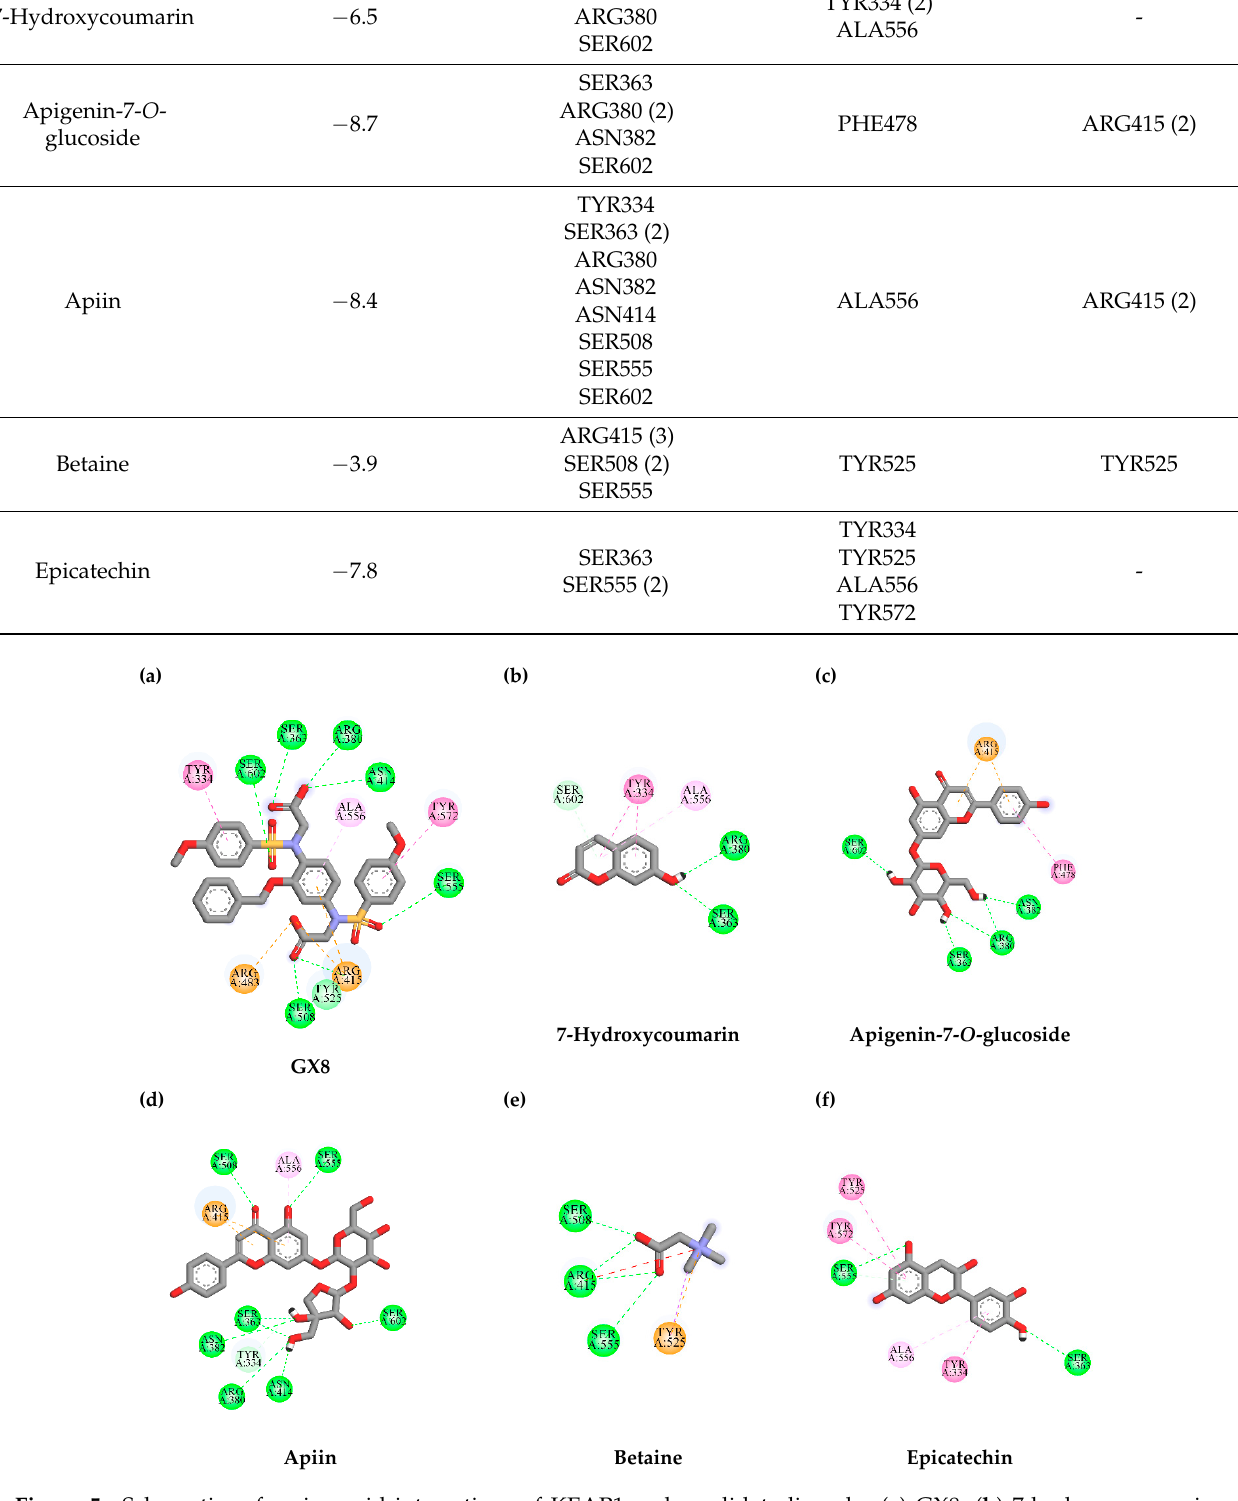
Figure 5. Schematics of amino acid interactions of KEAP1 and candidate ligands: ( a ) GX8, ( b ) 7-hydroxycoumarin, ( c ) apigenin-7- O -glucoside, ( d ) apiin, ( e ) betaine and ( f ) epicatechin. Green, pink and orange dashes indicate hydrogen, hydrophobic and electrostatic bonds, respectively.